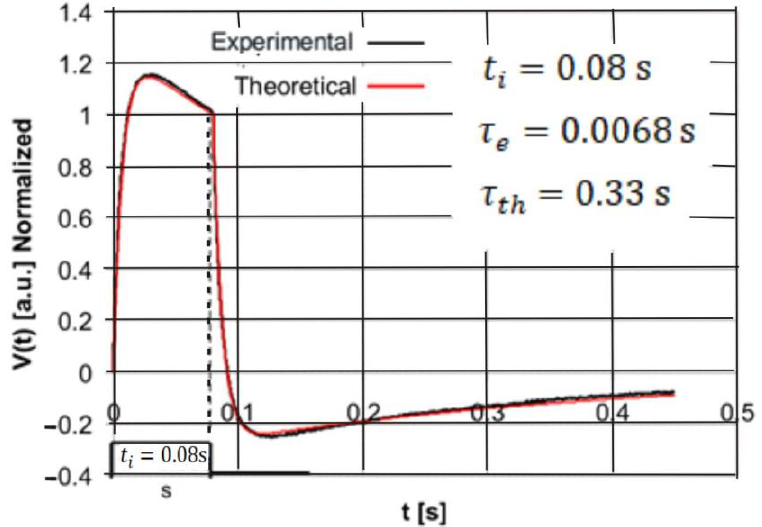
Figure 6. Comparison of the normalized experimental and theoretical voltage responses of the PE10-S-Q detector to the rectangular radiation pulse of duration t i = 0.08 s.